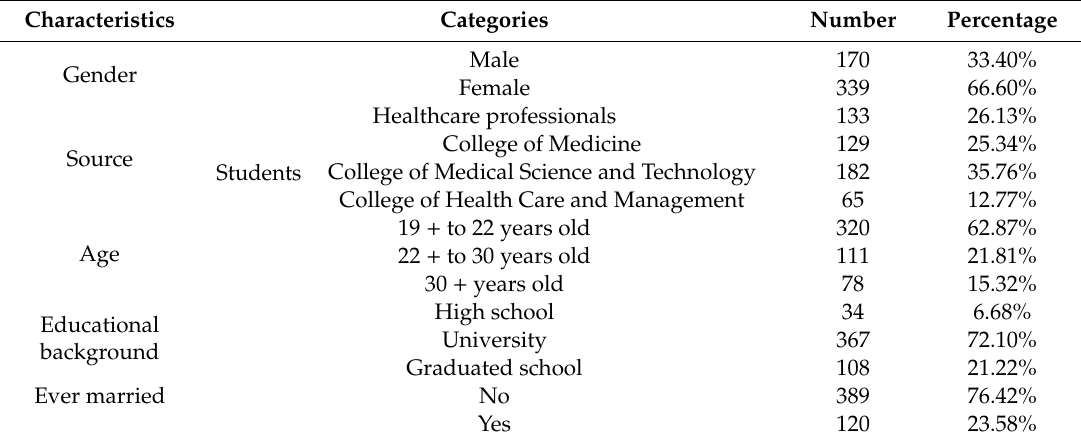
Table 1. Participants’ demographic